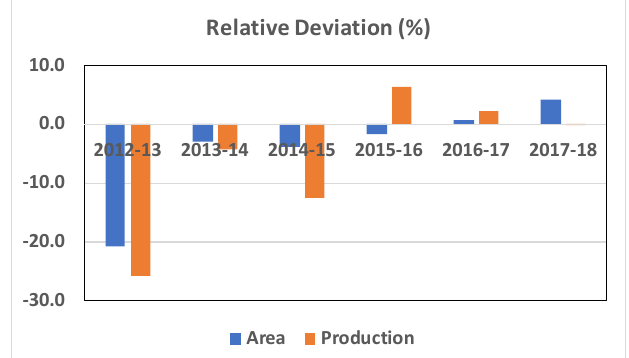
Figure 6. Relative Deviation (%) of remote sensing-based potato crop estimates, at national level, compared to government